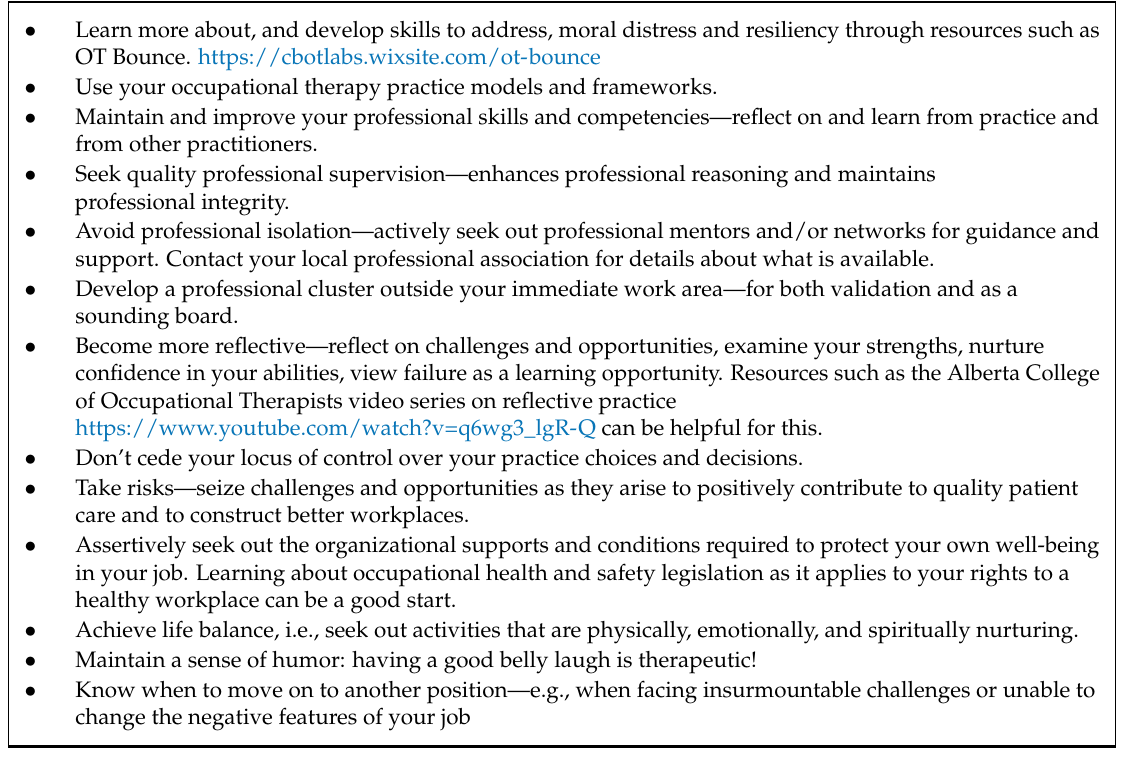
Table 4. Actions to build professional identity and